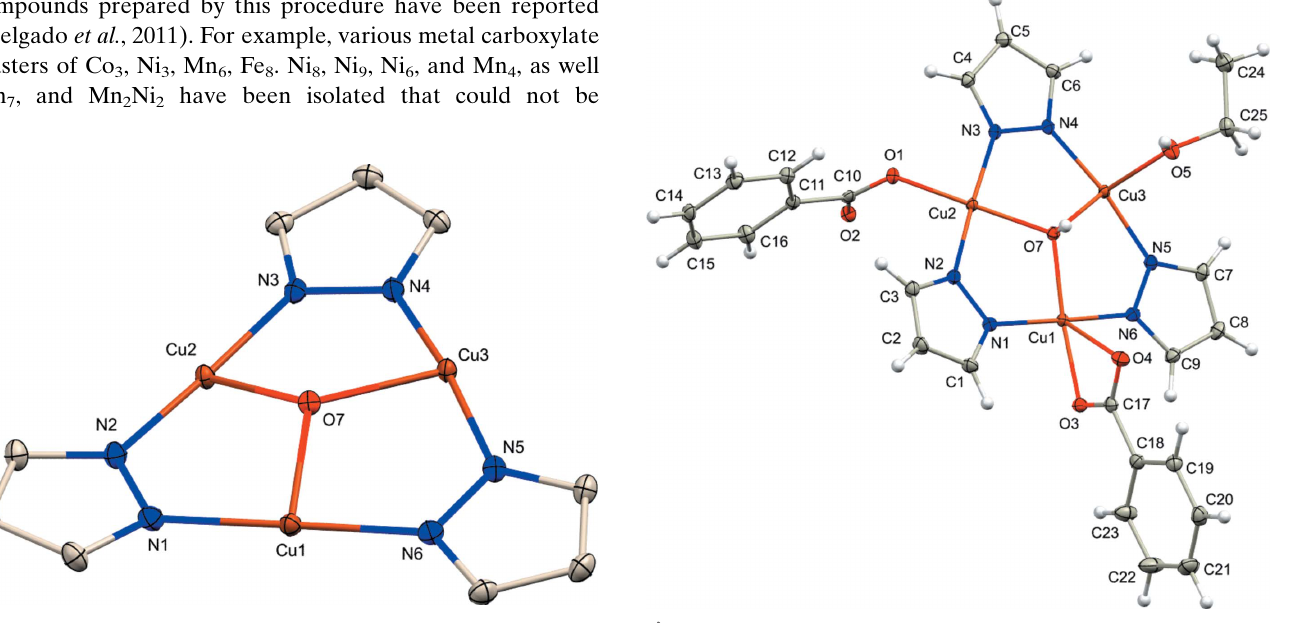
Figure 2 Asymmetric unit of the title compound with displacement ellipsoids drawn at the 50% probability level. The EtOH solvent molecule is omitted for